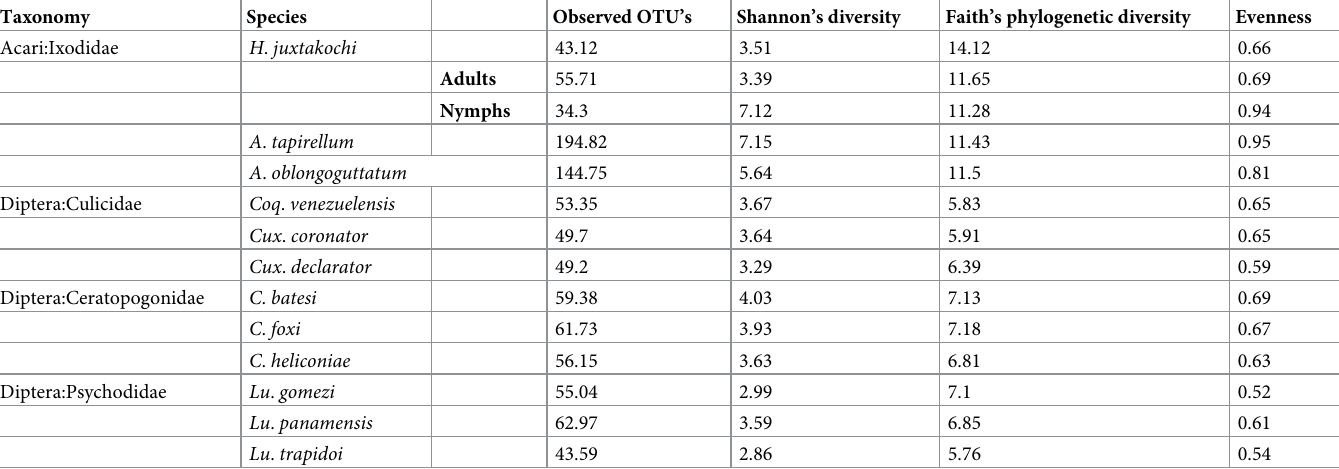
Table 1. Average measures of bacterial alpha diversity for 12 species of blood-feeding arthropods at a rarefaction depth of 7 000 16S sequences.